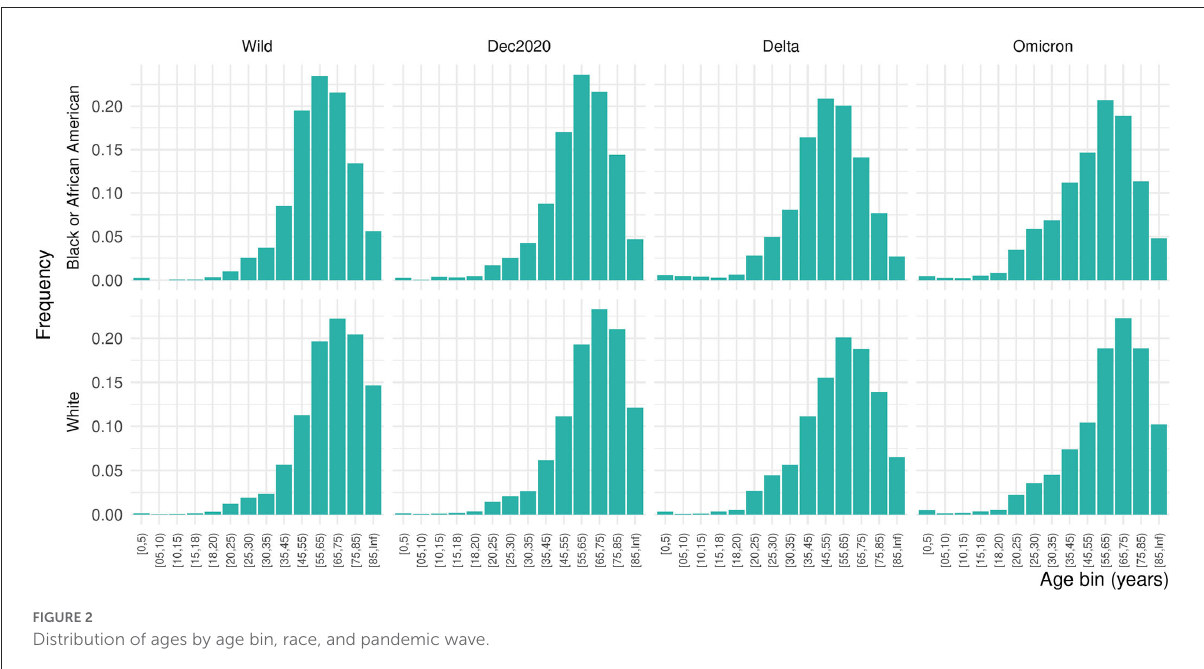
FIGURE2 Distribution of ages by age bin, race, and pandemic wave.